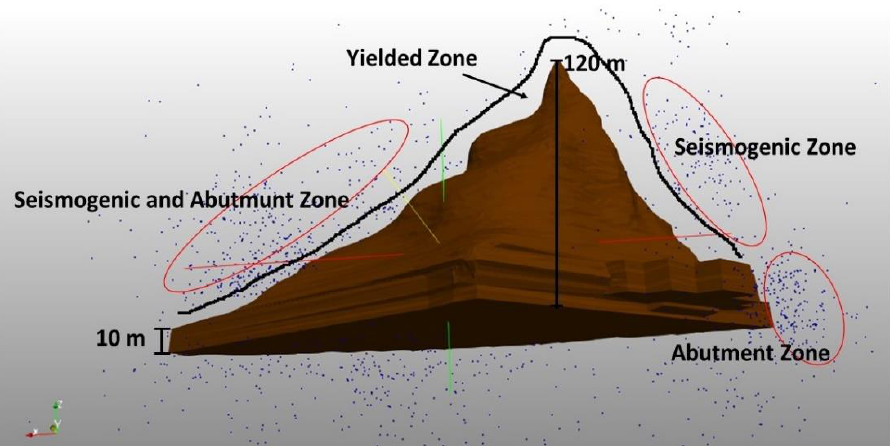
Figure 3. Conceptual caving model, showing the abutment zone, seismogenic zone and microseismic event distribution.